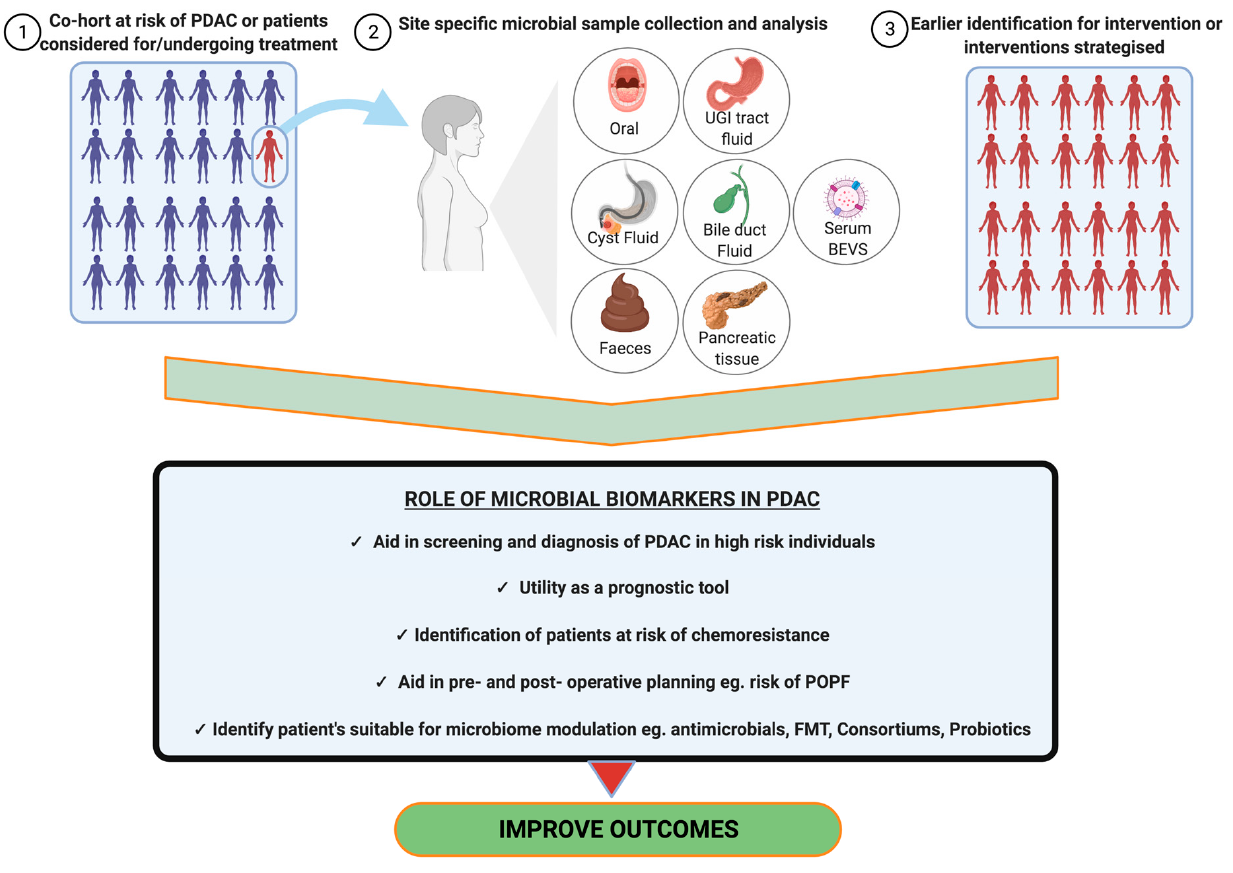
Figure 5. Conceptual application of microbial biomarkers in PDAC. In at risk cohorts, an array of site-specific sampling (non-invasive vs invasive) may provide an avenue for early detection of PDAC in at risk individuals, which may serve to identify more individuals suitable for intervention or alternatively may serve as a means for predicting outcomes of their disease and subsequent oncological therapies. Site specific microbial biomarkers or serum-based assays of bacterial endovesicles (BEVs) may be used in combination or in isolation at various stages in the patients journey with applications throughout the spectrum beginning at initial screening/diagnosis and spanning across to post-treatment surveillance.